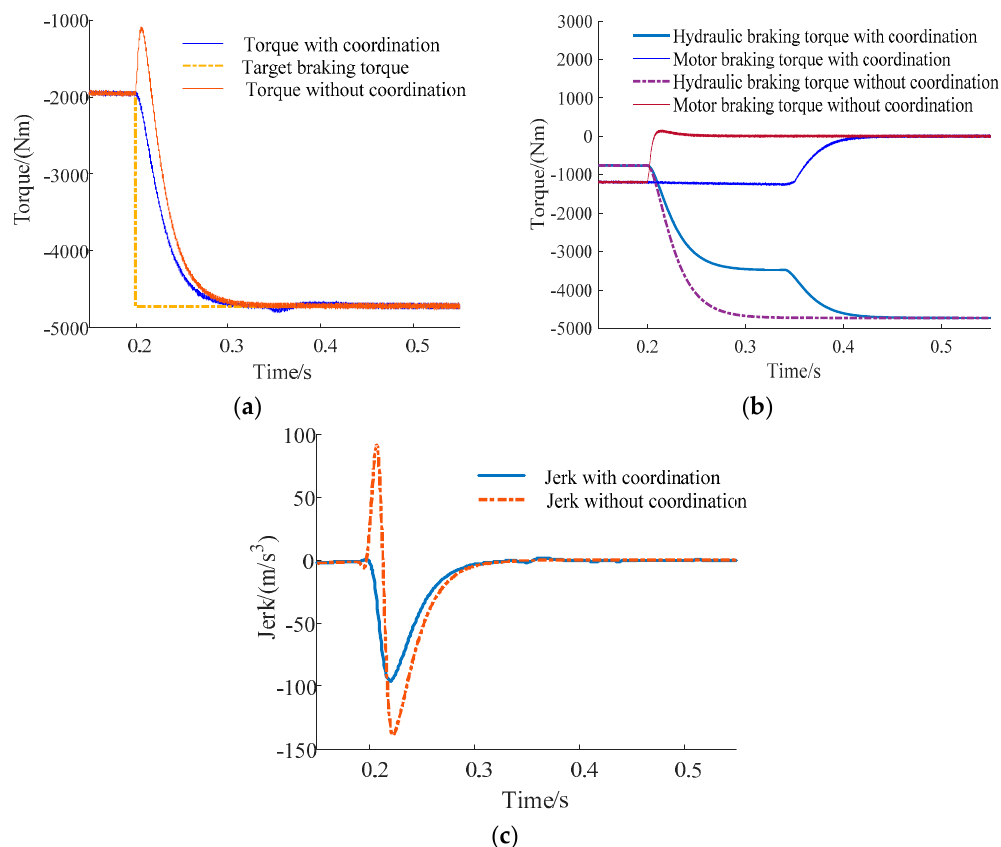
Figure 15. Simulation results of motor and hydraulic braking mode to hydraulic braking mode. ( a ) Total braking torque; ( b ) Motor and hydraulic braking torque; ( c ) Vehicle jerk .